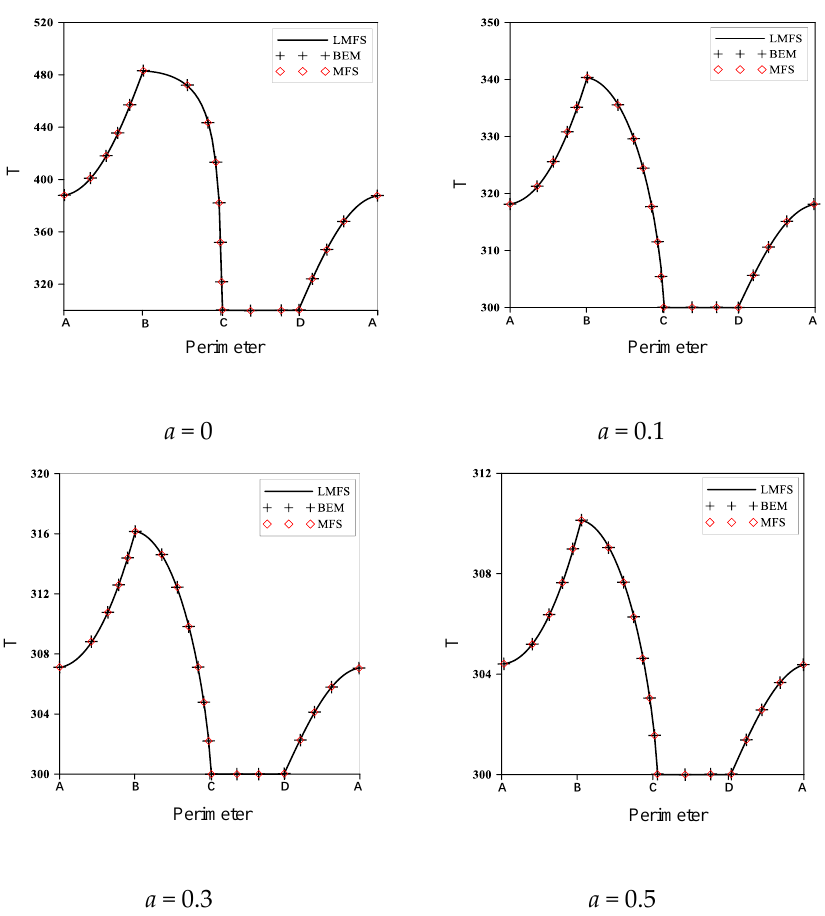
Figure 3. The boundary temperature when a = 0, 0.1, 0.3, 0.5.